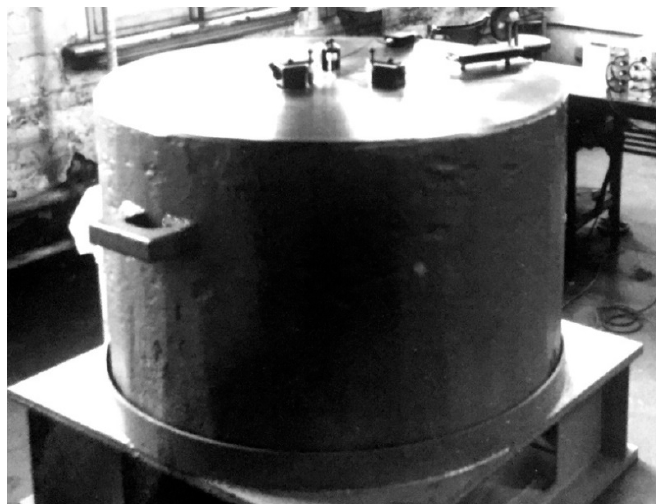
Figure 1. Steel block (1.1 m diameter, 0.76 m thickness) used for AE sensor calibration. Photograph provided by T. Watanabe of Nippon Steel Corp., Tokyo, Japan.